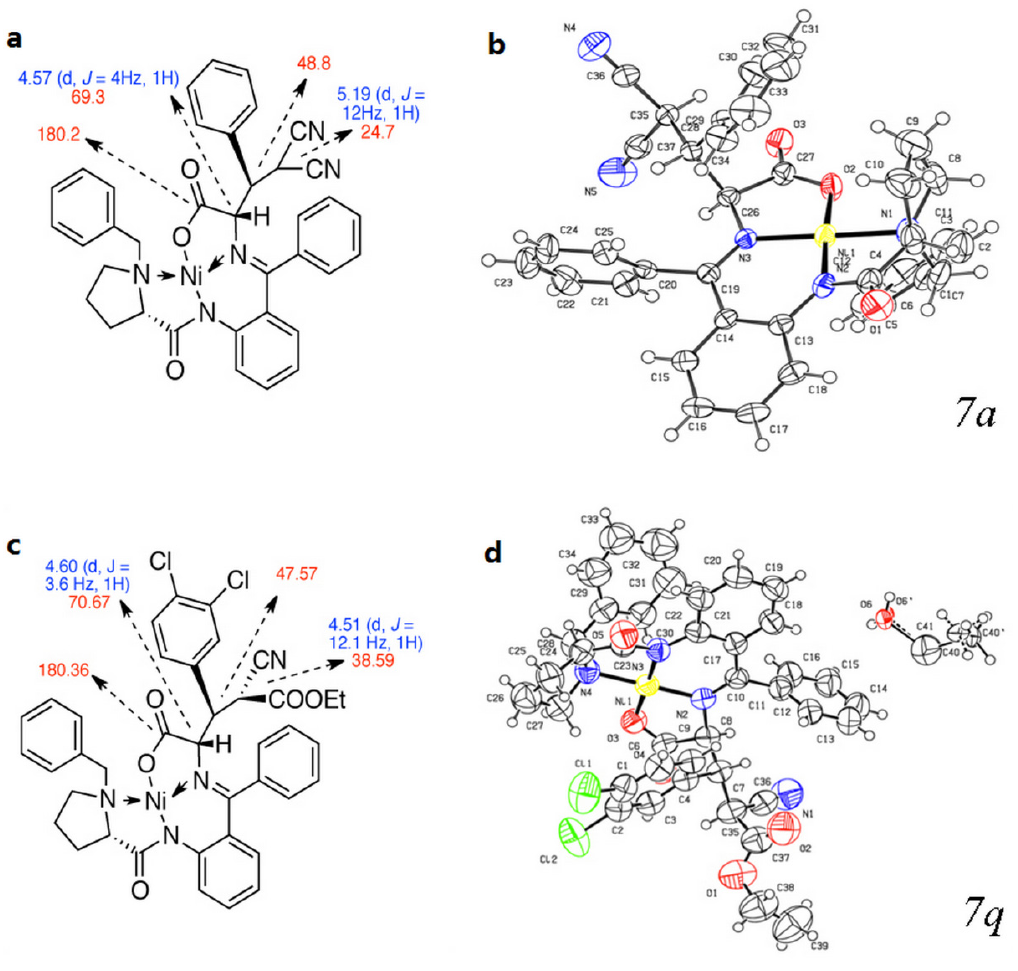
Figure 2. ( a ) Selected 1 H- and 13 C-NMR chemical shifts of ( S ,2 S ,3 R )- 7a ; ( b ) Single crystal X-ray diffraction study of ( S ,2 S ,3 R )- 7a ; ( c ) Selected 1 H- and 13 C-NMR chemical shifts of ( S ,2 S ,3 R ,4 S )- 7q and ( d ) Single crystal X-ray diffraction study of ( S ,2 S ,3 R ,4 S )- 7q